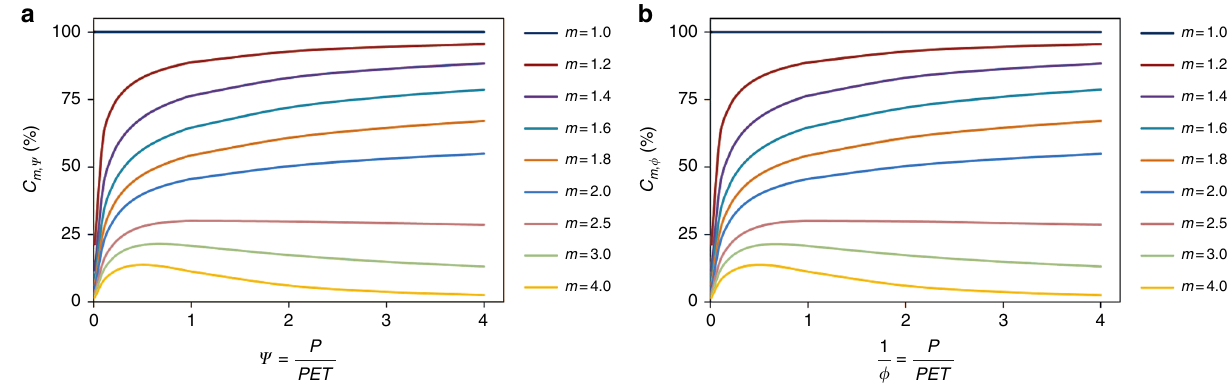
Fig. 1 The relative contribution of m to changes in R / P with regard to P /PET. a C m, ψ is computed using the wetness index given by Eq. (3) and b C m, ϕ is computed using the dryness index given by Eq. (6)